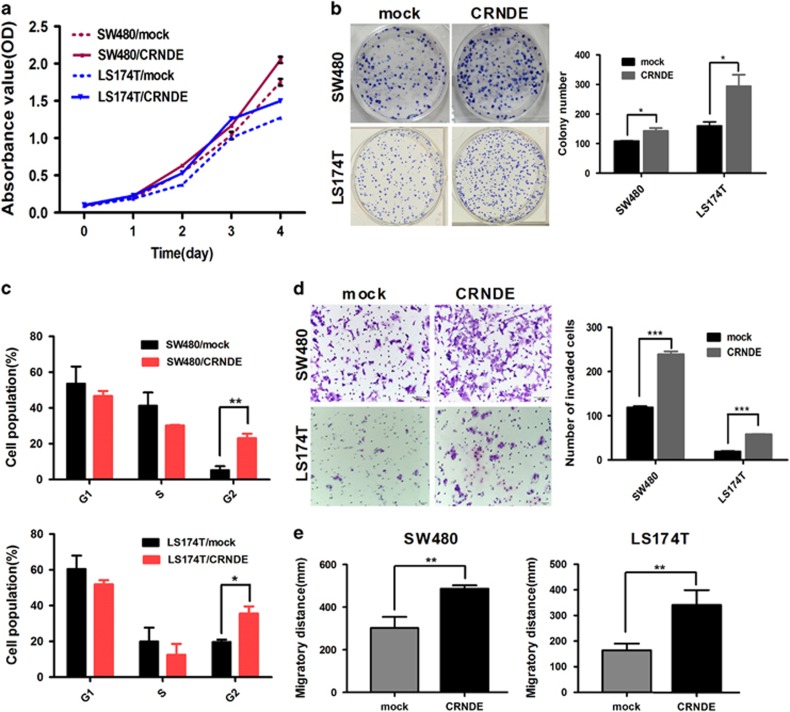
Overexpression of CRNDE promotes cell proliferation, cell cycling, invasion and migration in CRC cells in vitro. (a) Overexpression of CRNDE induced significantly higher growth rates in CRC cells. (b) Overexpression of CRNDE increased the capacity to form colonies in CRC cells. (c) Overexpression of CRNDE induced a significant increase in cells at G2-phase relative to mock cells. (d and e) Invasion/migration assays using Matrigel Transwell and wound-healing assays for CRC cells. CRNDE overexpression promoted the invasion and migration of CRC cells. The experiments were performed in triplicate; the data are expressed as the mean±S.D. *P<0.05, **P<0.01 and *** P<0.001